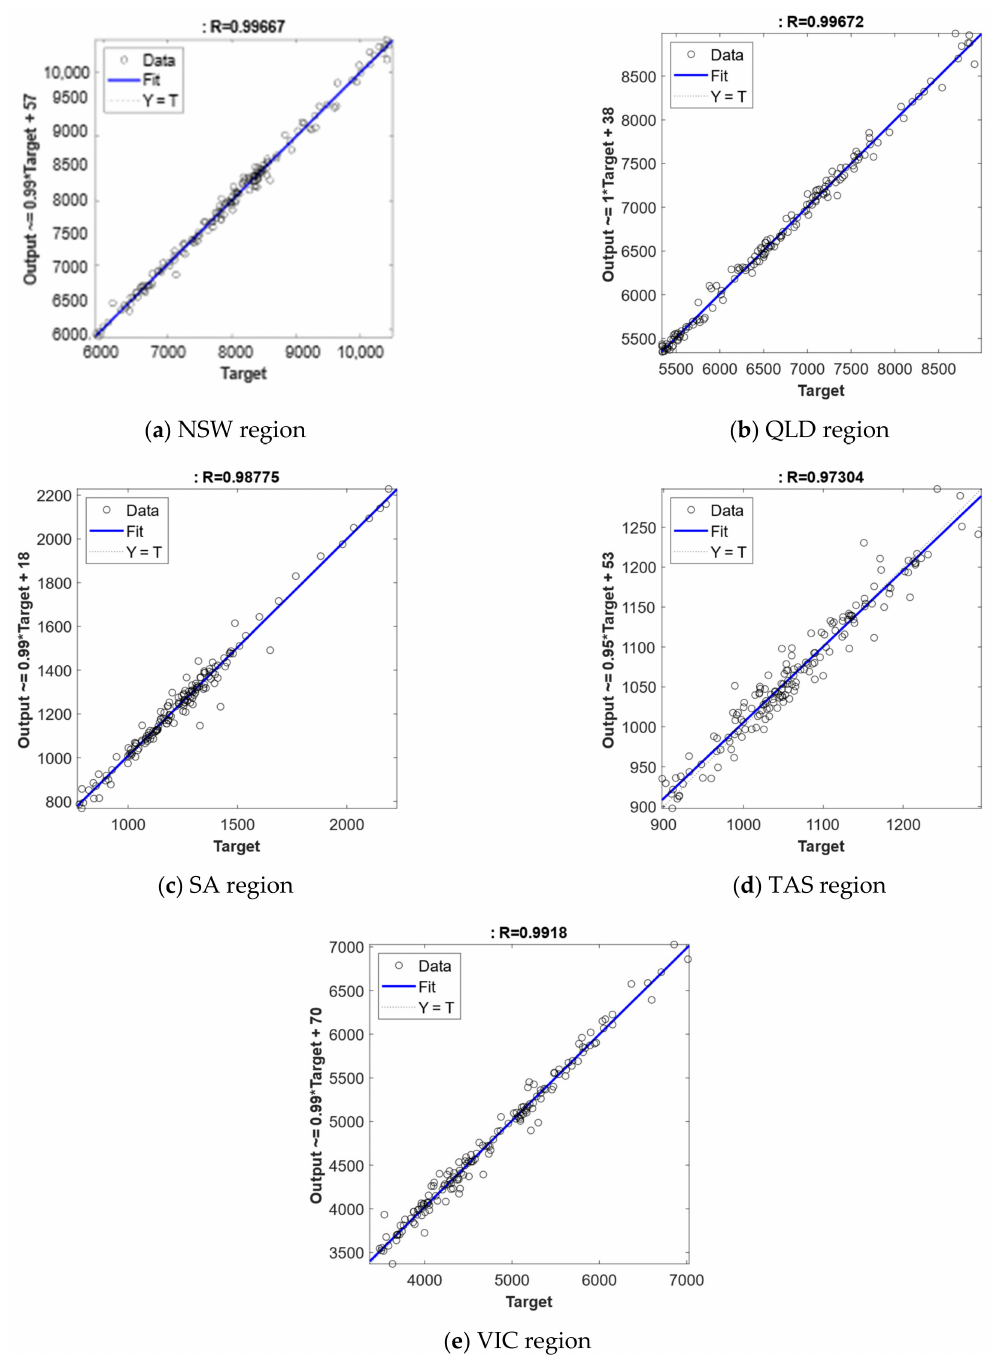
Figure 9. Regression analysis of the proposed prediction method for five regions of Australia electrical load dataset (train set): ( a ) NSW, ( b ) QLD, ( c ) SA, ( d ) TAS, ( e )